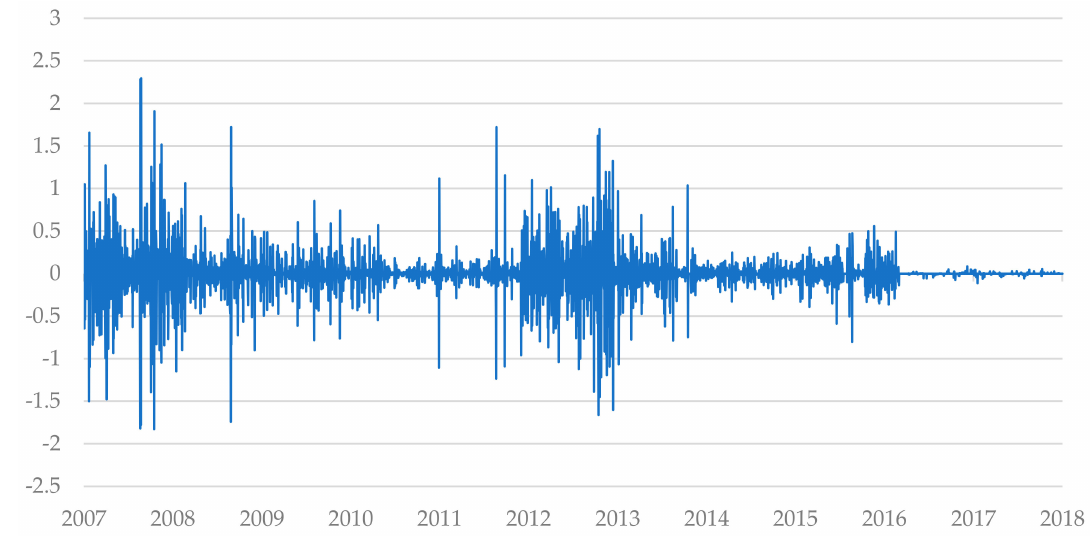
Figure 2. New Jersey Solar Renewable Energy Credit (SREC) prices log returns.